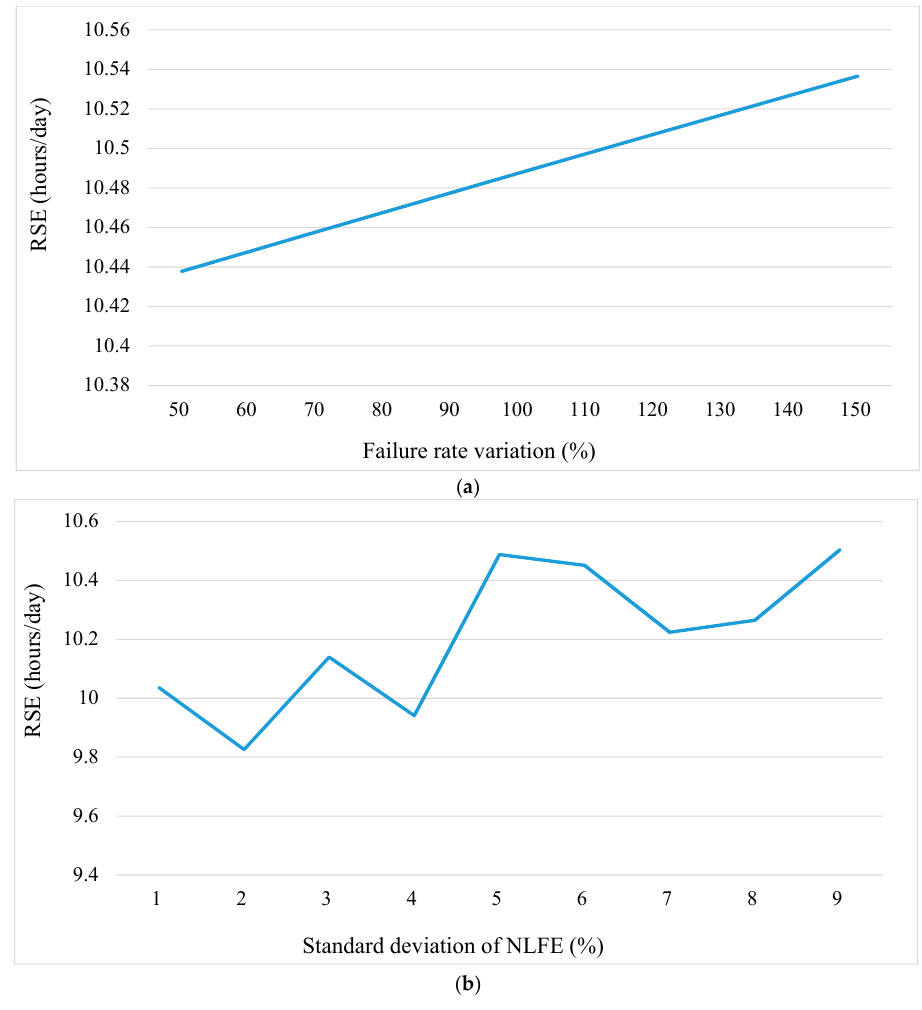
Figure 8. Results of sensitivity analysis: ( a ) RSE and failure rates of generators; ( b ) RSE and standard deviation of net load forecast error ( NLFE ).